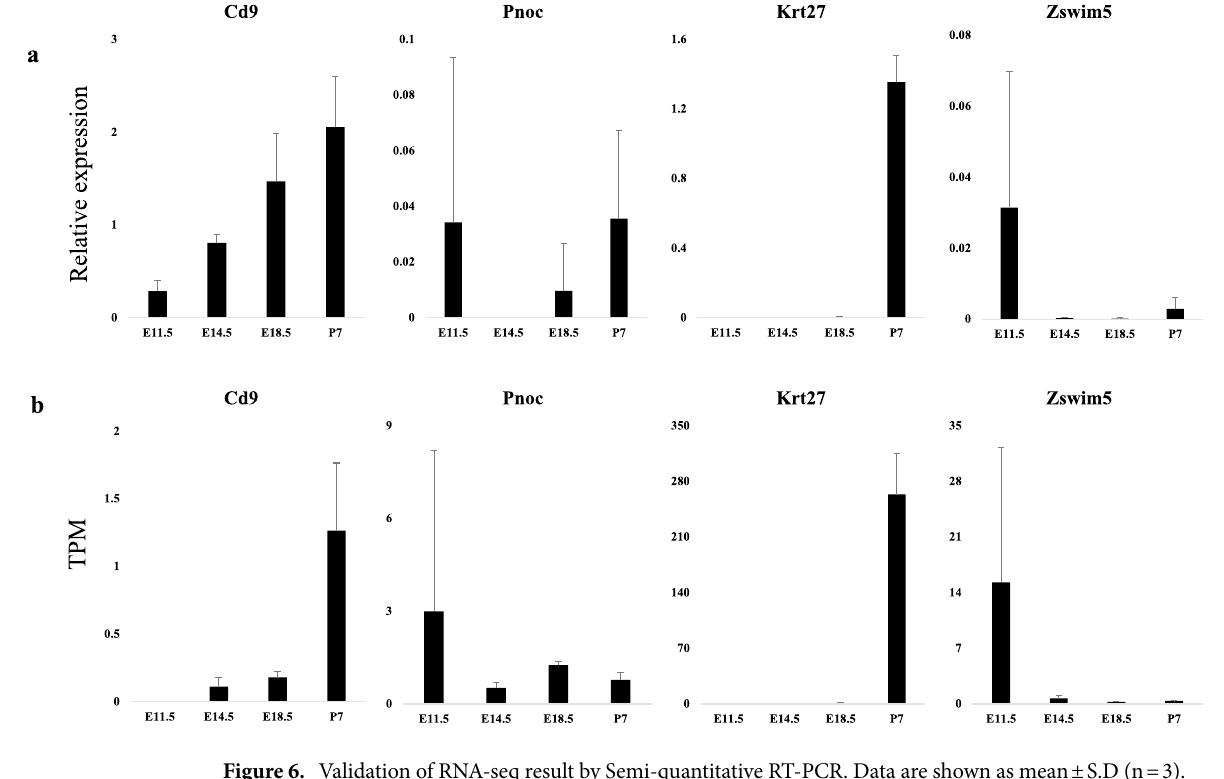
Figure 6. Validation of RNA-seq result by Semi-quantitative RT-PCR. Data are shown as mean ± S.D (n = 3). ( a ) Semi-quantitative RT-PCR result of Cd9, Krt27, Zswim5 and Pnoc at E11.5, E14.5, E18.5 and P7. Gene expressions were normalized by housekeeping gene Gapdh. ( b ) RNA-seq result of Cd9, Krt27, Zswim5 and Pnoc at E11.5, E14.5, E18.5 and P7. TPM refers to Transcript per